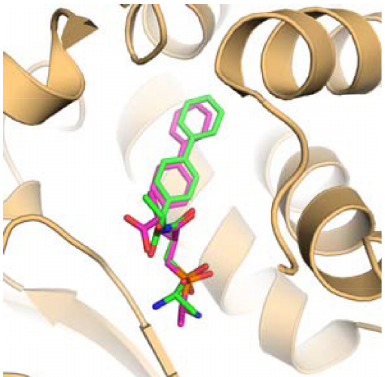
FIGURE 4 - Superimposition of the redocking pose (magenta) and the ligand pose in the co-crystal structure (green). The receptor is shown in cartoon representation and is coloured light orange.